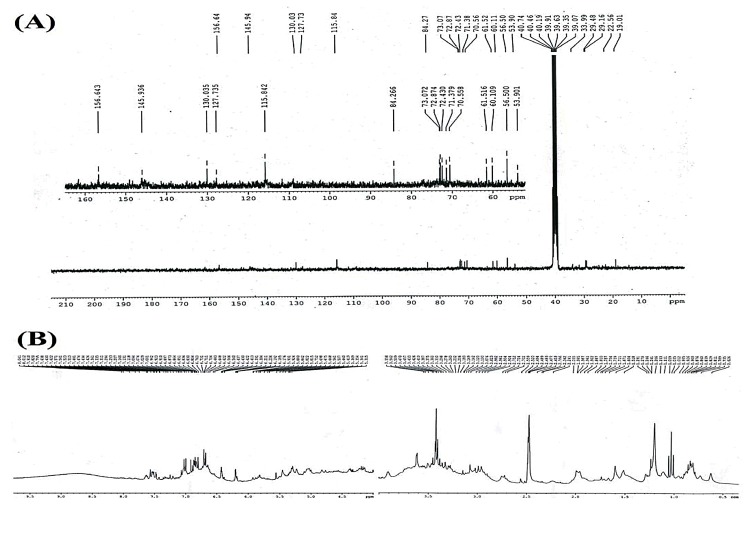
(A) 13C NMR spectra and (B) 1H NMR spectra of ACL extract.